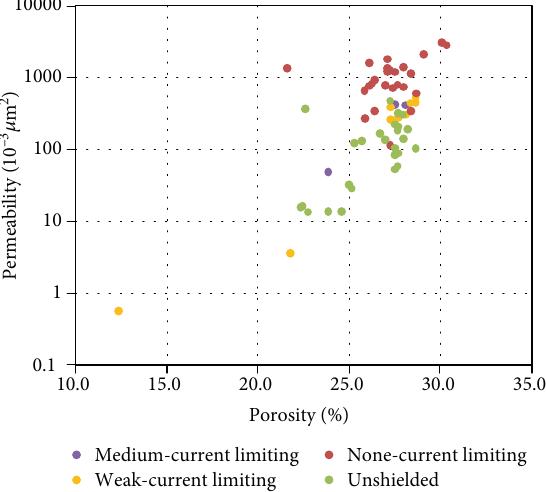
Figure 14: Scatter plot of permeability and porosity in di ff erent fl ow